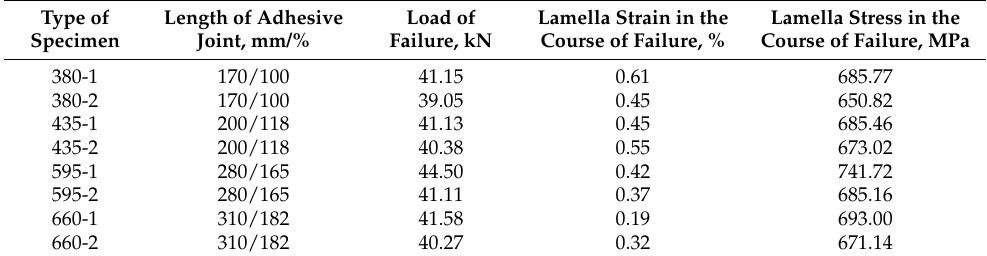
Table 4. The adhesive joint testing results.